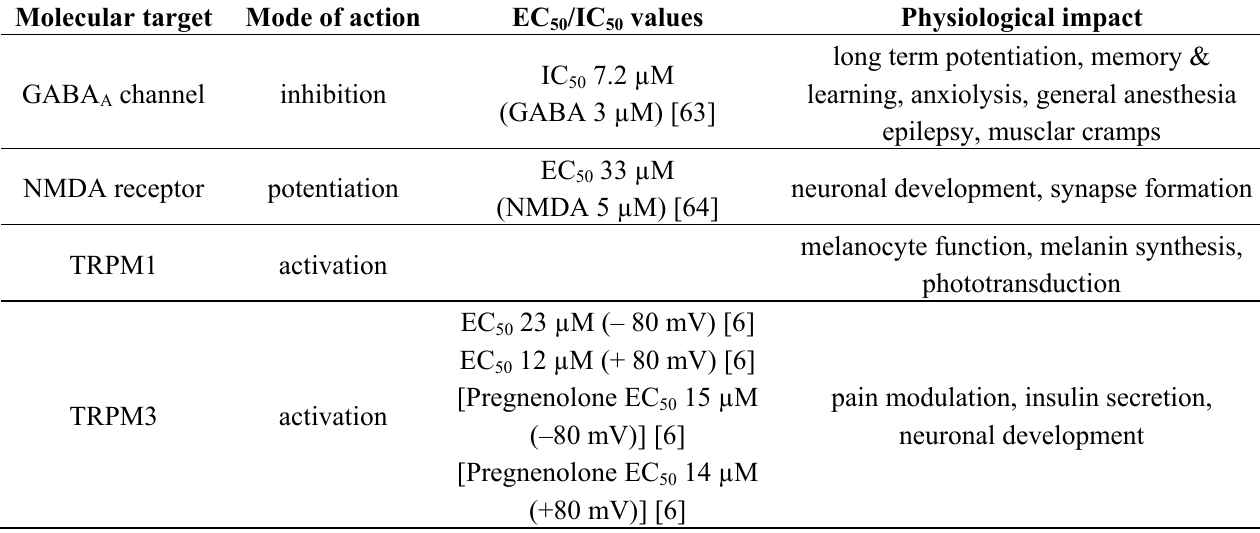
Table 1. Molecular targets of pregnenolone